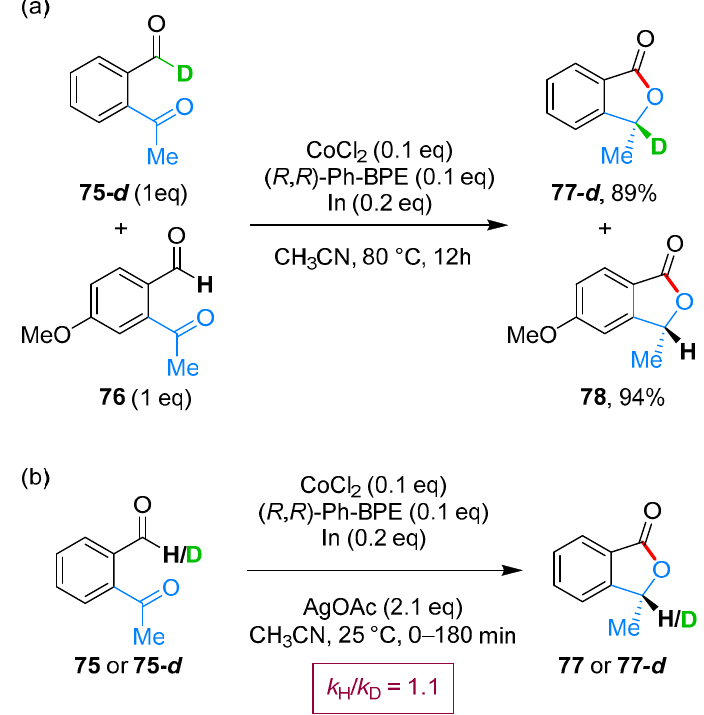
Scheme 43. Deuterium-labelling experiments for the Co-catalyzed hydroacylation of o -ketobenzaldehydes.